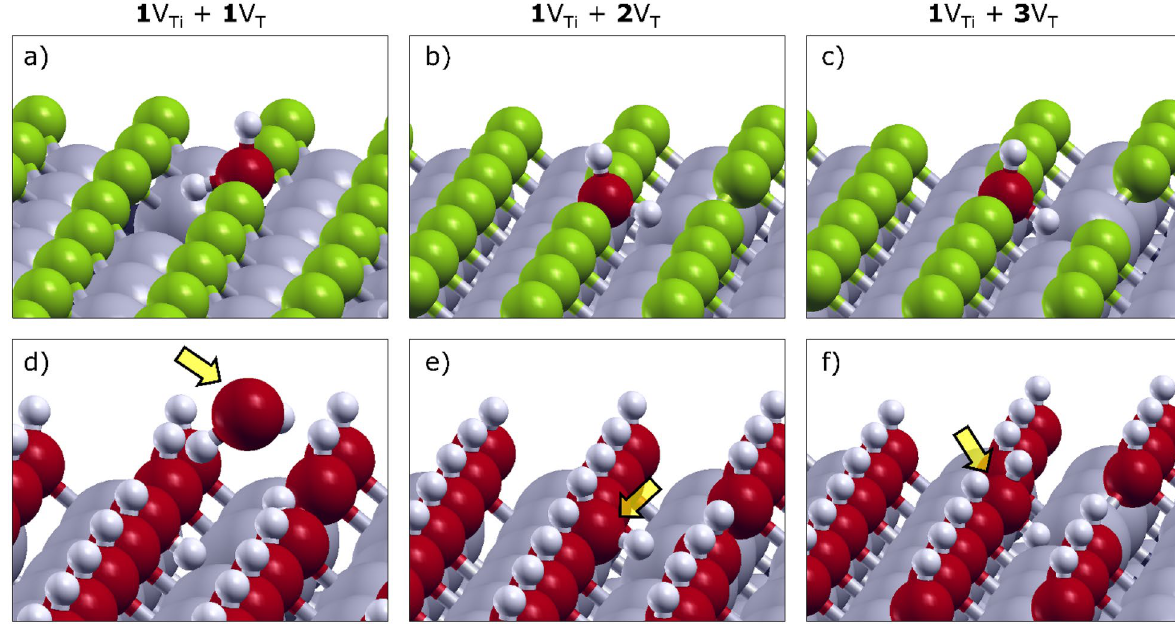
Fig. 4 Optimized configurations of H 2 O adsorbed on different clusters of vacancies for Ti 2 CF 2 ( a – c ) and Ti 2 C(OH) 2 ( d – f ). The clusters of defects consist of one titanium vacancy and up to three termination vacancies, as 1V Ti highlights the presence of the water molecule interacting with the defected Ti 2 C(OH) 2